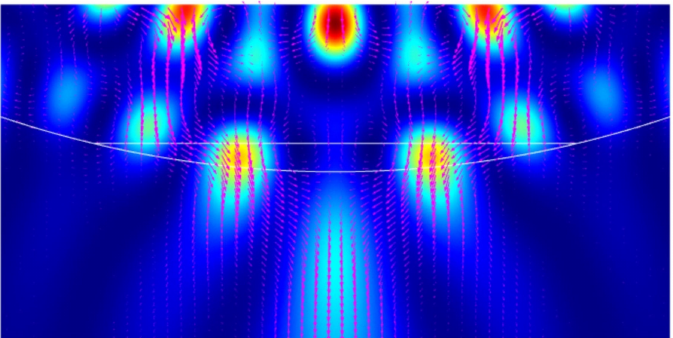
Figure 5. Distribution of the Poynting vector around the hot spots of the Janus